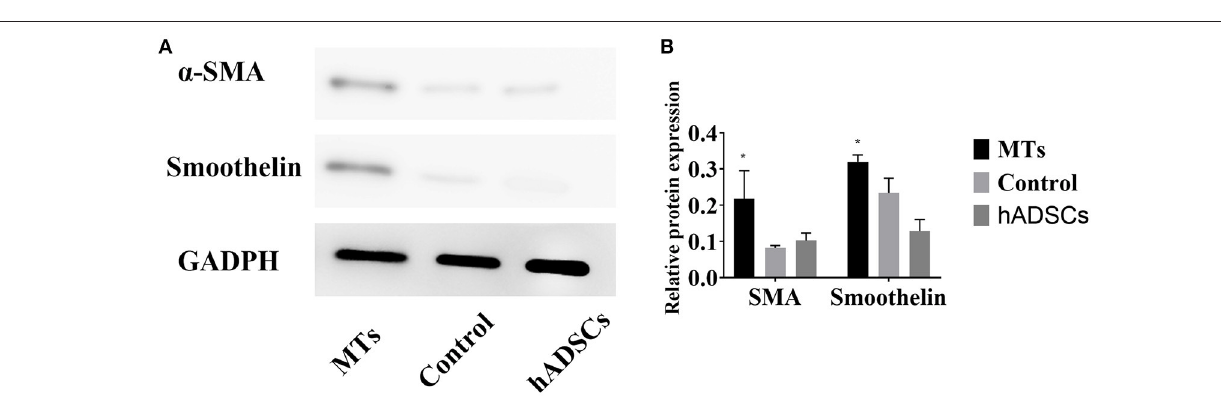
Frontiers in Physiology | www.frontiersin.org